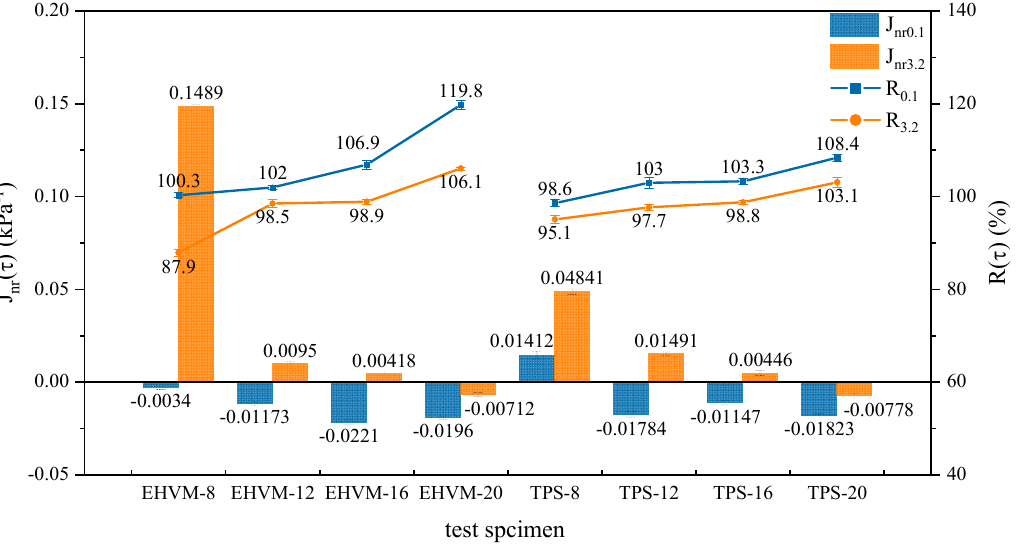
Figure 7. MSCR test results for different HVA. Note: In the figure, the error bars represent the standard deviation of three parallel experiments. The same in the following figure.